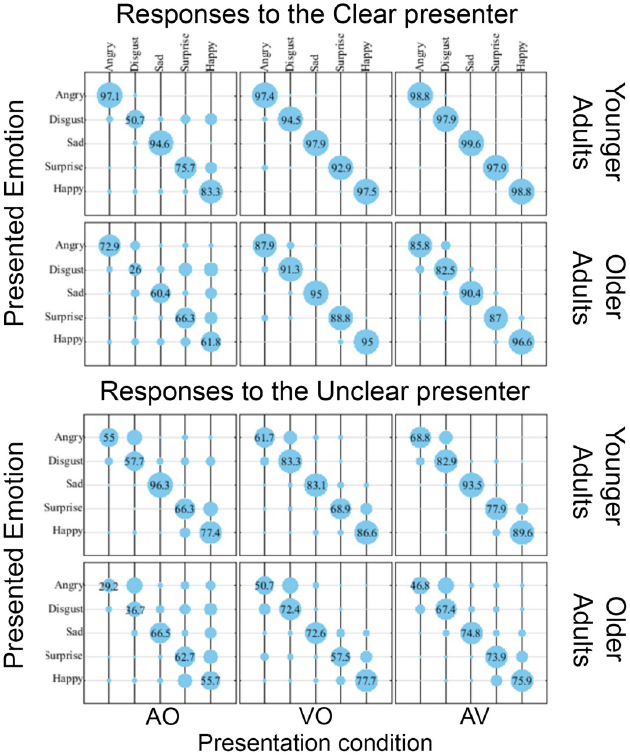
Fig 2. Response matrices for the AO (left column), VO (middle column), and AV (right column) presentation conditions for the Clear presenter (top two rows) and Unclear presenter (bottom two rows). Each pair of rows show the response matrices for the younger adults (top) and older adults (bottom). The presented emotions are shown on the vertical and the responses to these are shown at the top, horizontally. Response magnitude is represented by the size of the circles; the numbers reported on the diagonal have been added to indicate scale and are the mean percentage of times that a response was selected for a presented emotion. unclear presenter for the Auditory only (AO), Visual Only (VO) and Auditory-Visual (AV) presentation conditions. The size of the blue circles represents the percentage of each response. For example, the large blue circled on the diagonals of each matrix represent correct recogni- tion (with the percent response scores shown). The smaller, off-diagonal circles represent